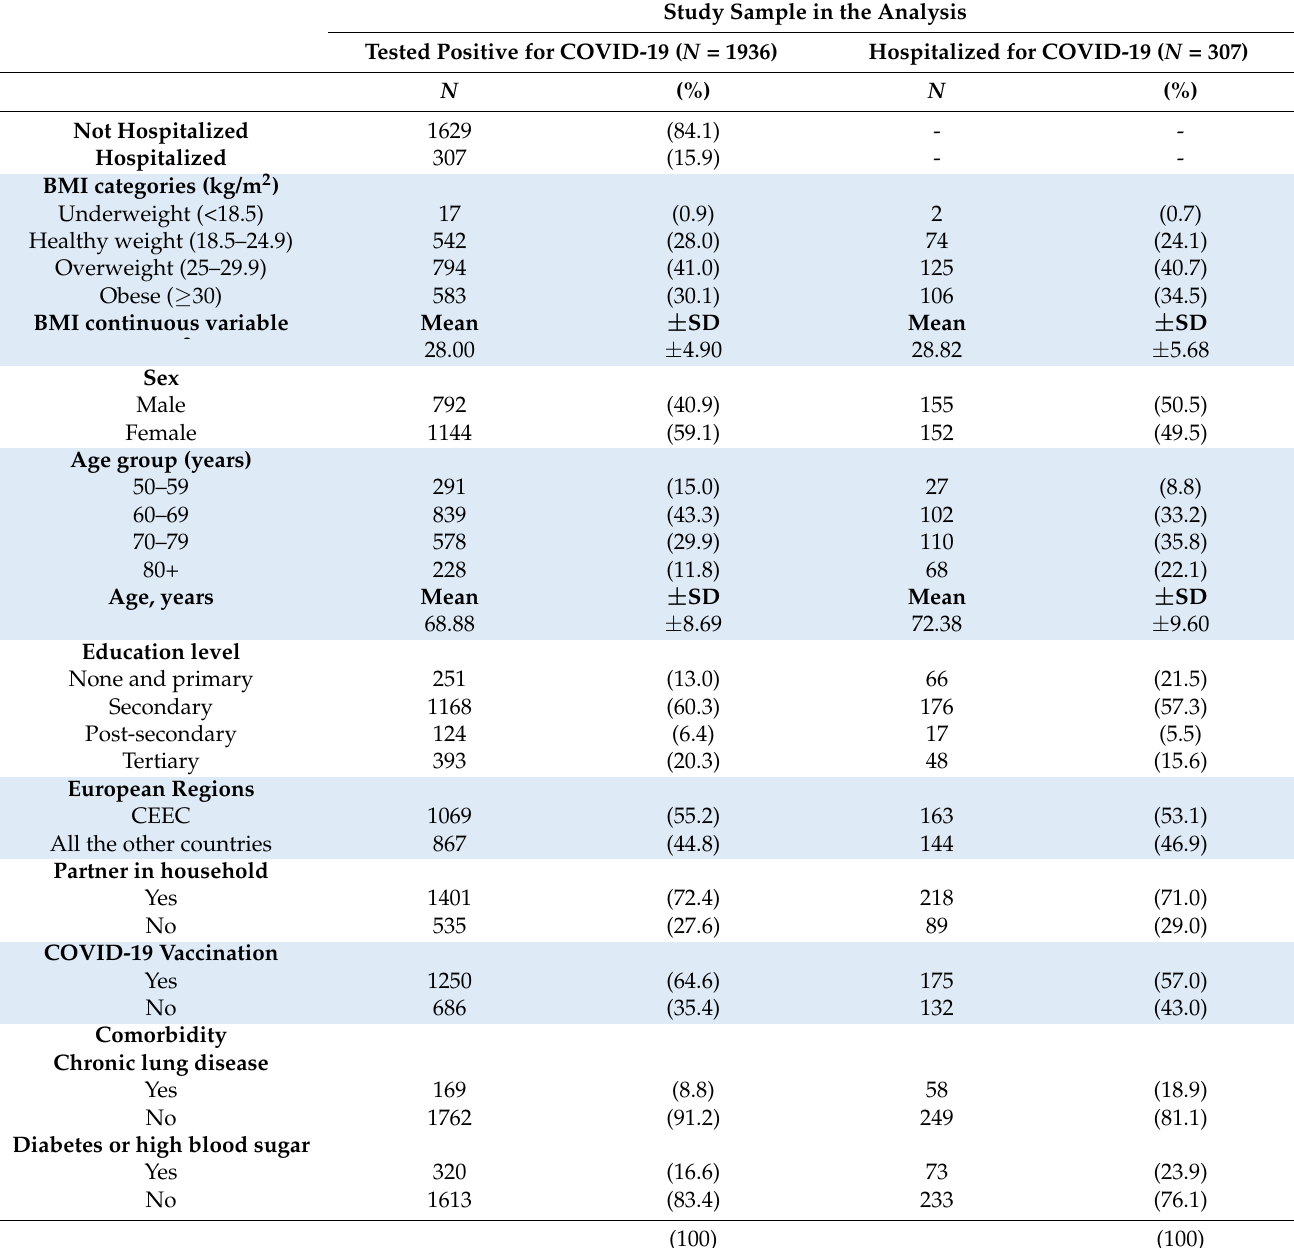
Table 1. Descriptive characteristics of the study sample by COVID-19 test and